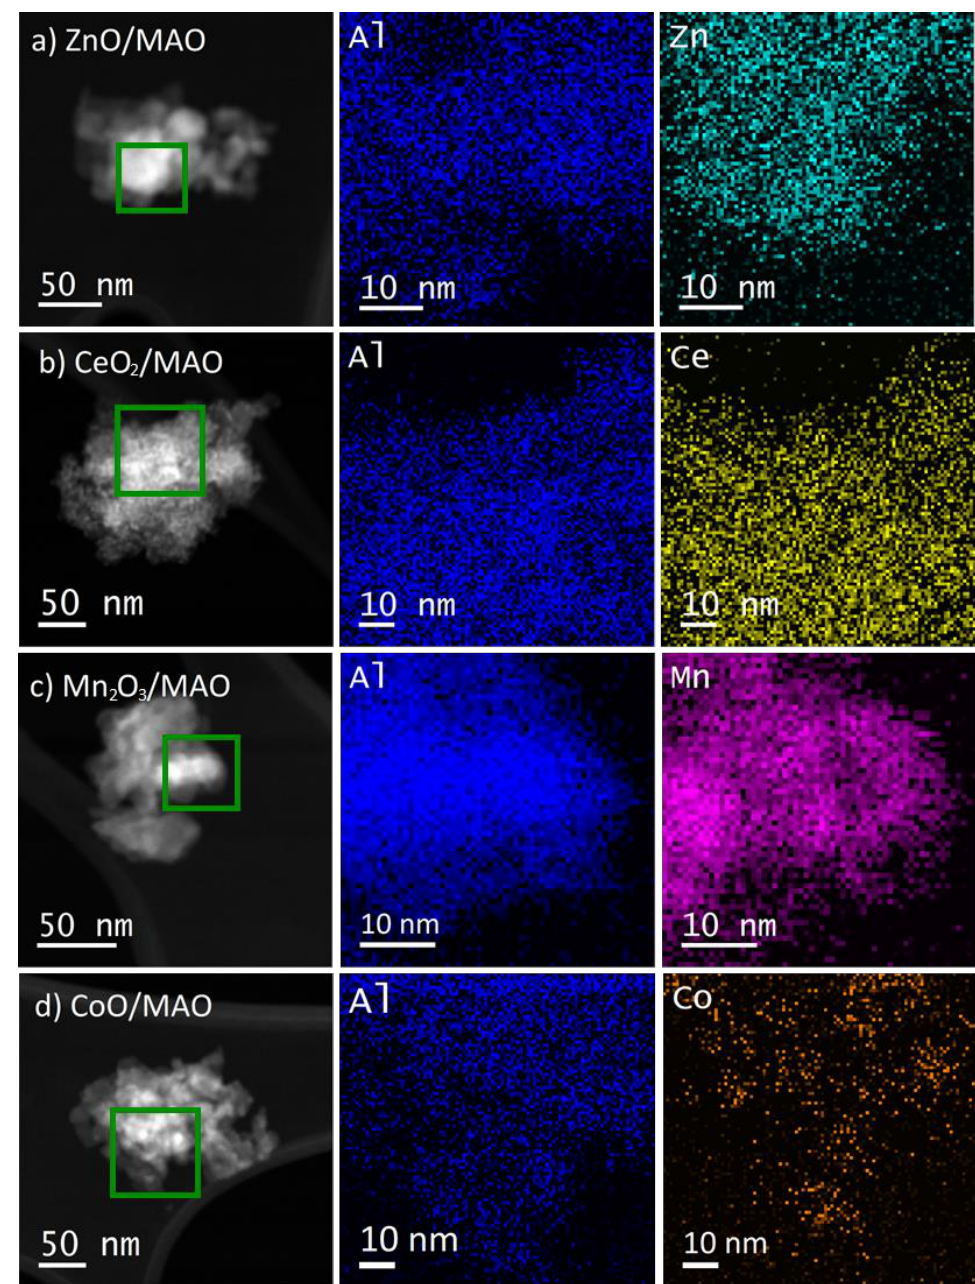
Figure 2. High angle annular dark field STEM images and EDS maps taken from the regions in green boxes for the ALD-modified supports ( a ) ZnO/MAO, ( b ) CeO 2 /MAO, ( c ) Mn 2 O 3 /MAO, ( d ) CoO/MAO.